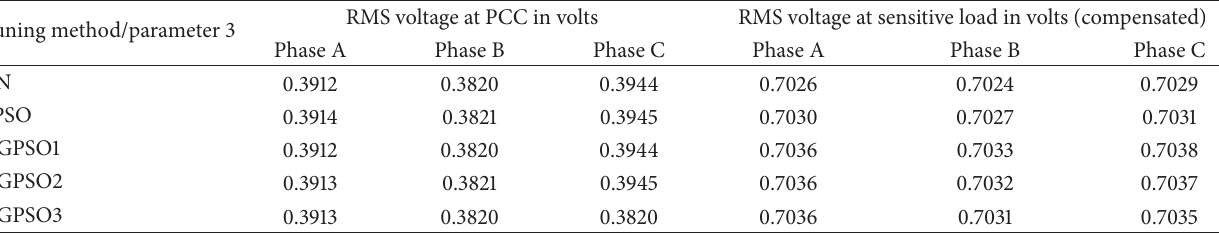
Table 7: RMS voltage variation of rectifier load.